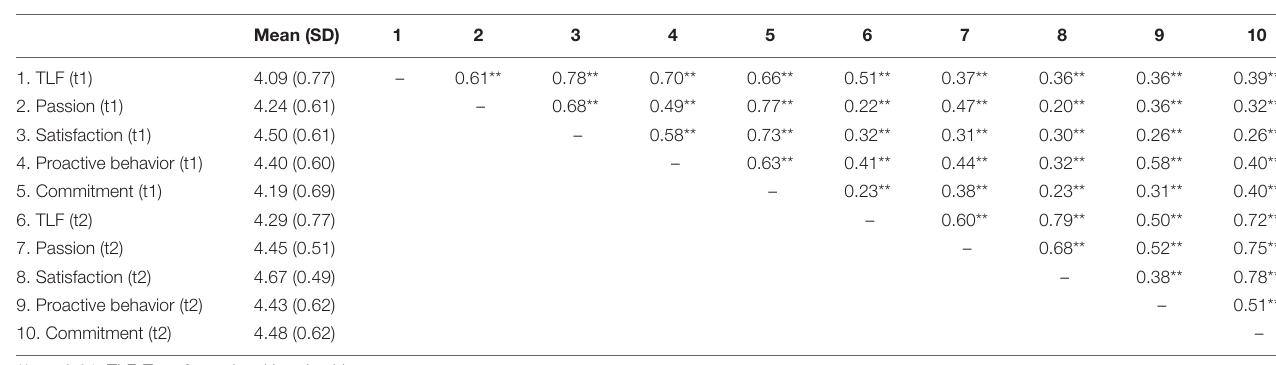
TABLE 2 | Descriptive statistics and correlations between variables.